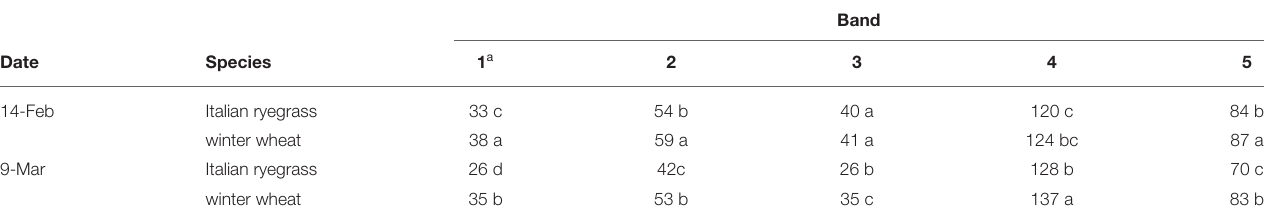
TABLE 3 | Spectral reflectance values within distinct bands of Italian ryegrass and winter wheat across imaging